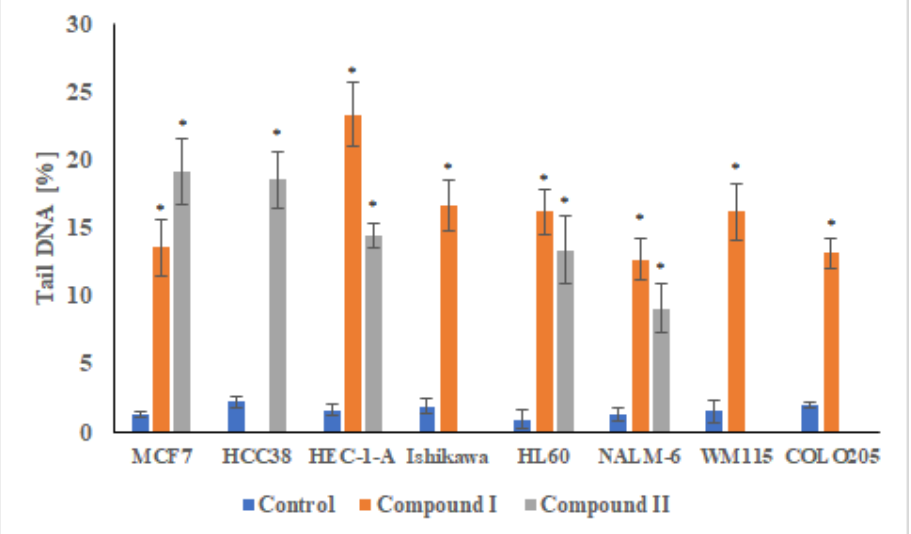
Figure 8. DNA content in the tail of the comet obtained from MCF7, HCC38, HEC-1-A, Ishikawa, COLO205, HL60, NALM-6, and WM115 treated with control and test compounds for 24 h. The DNA tail fraction was estimated at the end of the incubation period using an alkaline version of the comet assay. Each experiment was performed at least in triplicate. The results represent mean ± SEM of the data from 3 individual experiments, and for each analysis, 100 randomly chosen comets were counted, * p < 0.05 vs. control.